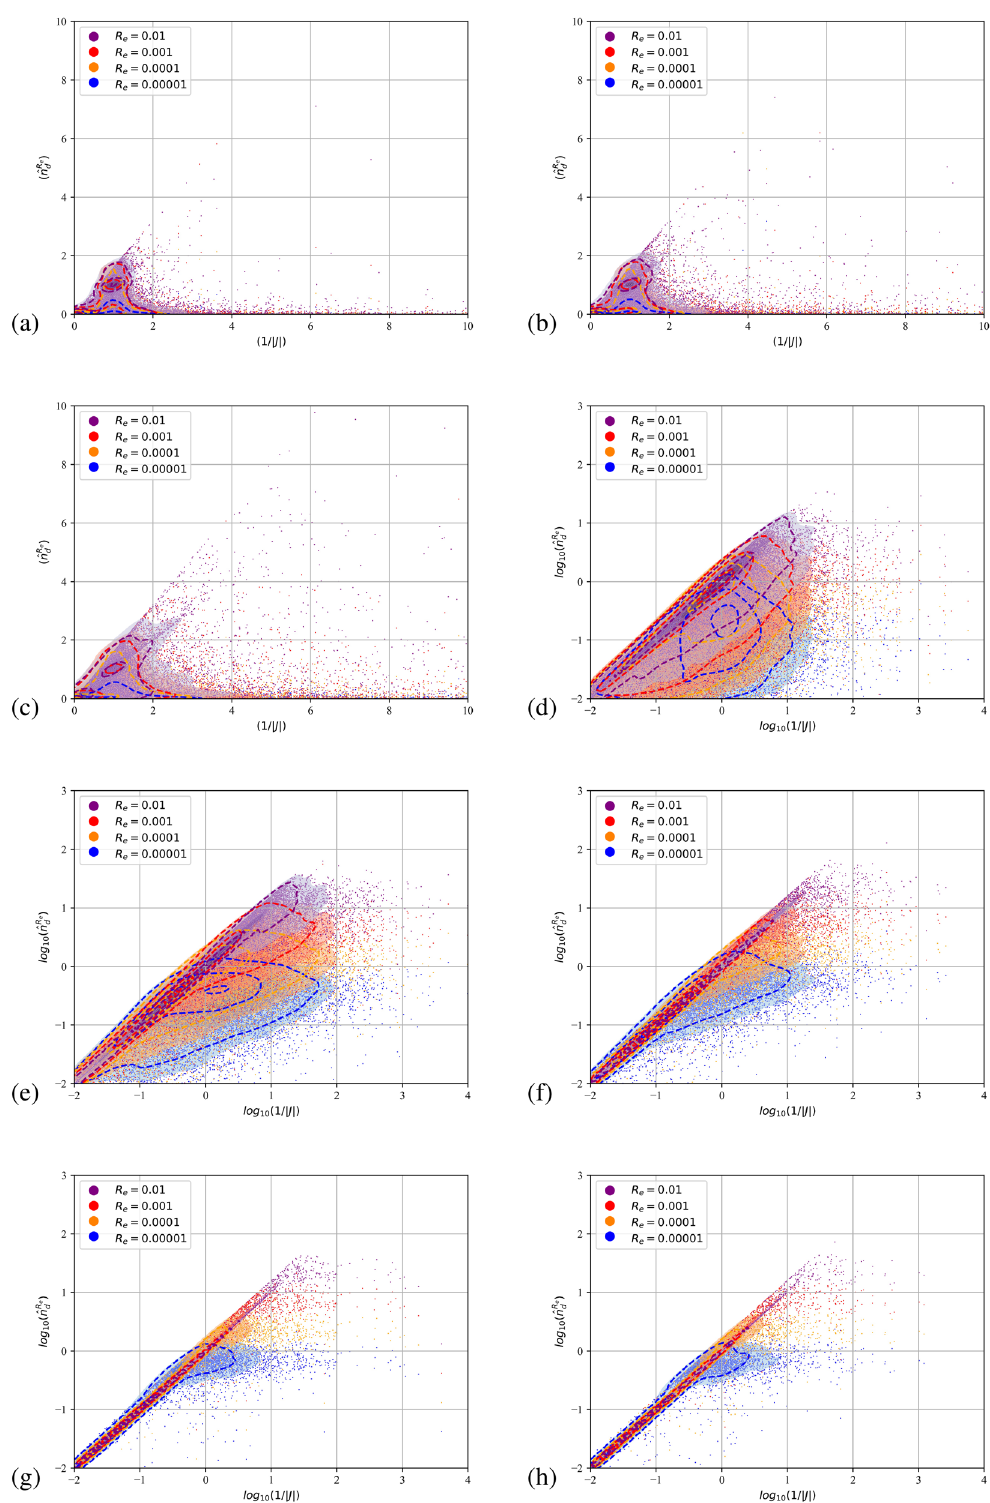
Figure 7. Scatter plot of the filtered FLA2 number density versus 1/ J . Colours correspond to the filtering length. Dashed iso-lines correspond to the kernel density estimation at levels 10% 50% and 90%. Case C3DN6. T = 8 ms. ( a – h ) D d = 0.5 – 100 µ m. ( d – h ) are presented in logarithmic